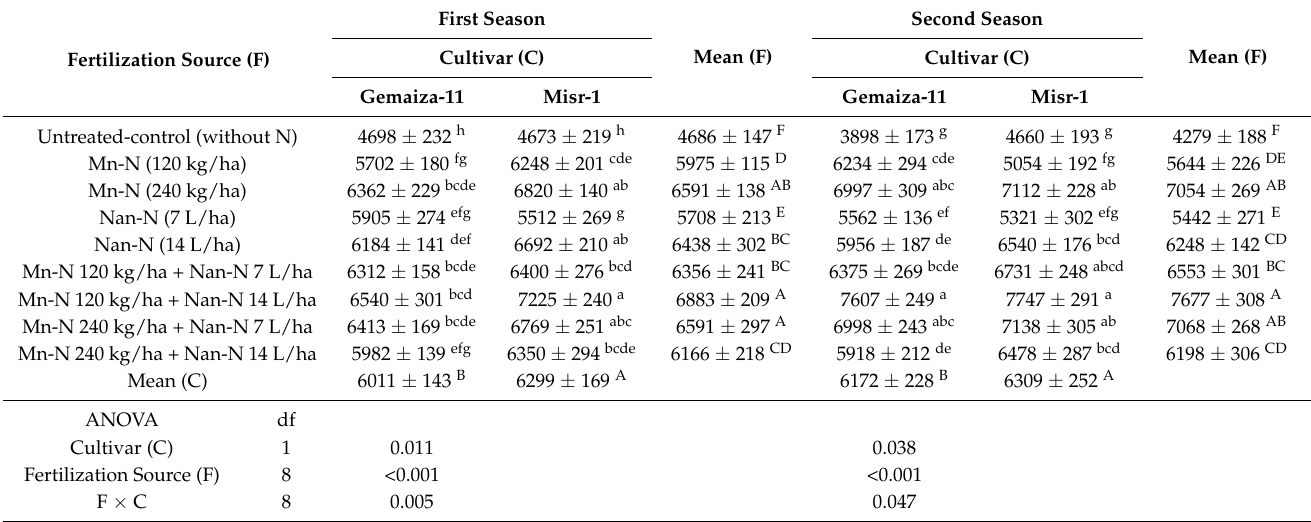
Table 8. Impact of nano- and mineral nitrogen fertilizers on the grain yield (kg/ha) of two wheat cultivars during the 2019/2020 and 2020/2021